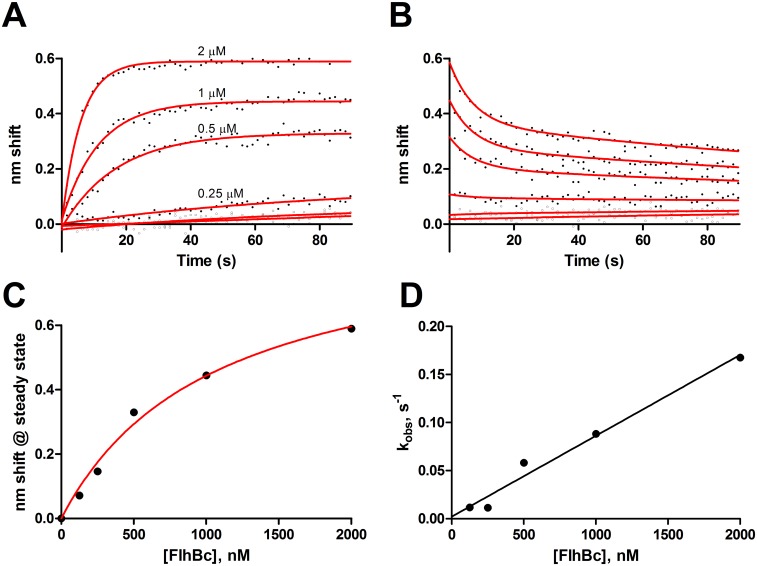
FlhAC-FlhBC binding.Ligand FlhAC was exposed to 2, 1, 0.5, 0.25 and 0.125 μM FlhBC. A, association with fits to a one-state model B, dissociation with fits to a global two-state model C, steady state analysis. D, kobs vs. [FlhBC] to estimate kinetic constants, R2 = 0.98.